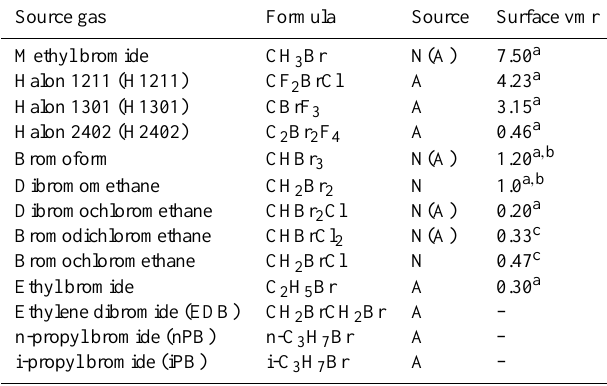
Table 1. Model Br-containing source gases and assumed surface volume mixing ratio (vmrppt − 1